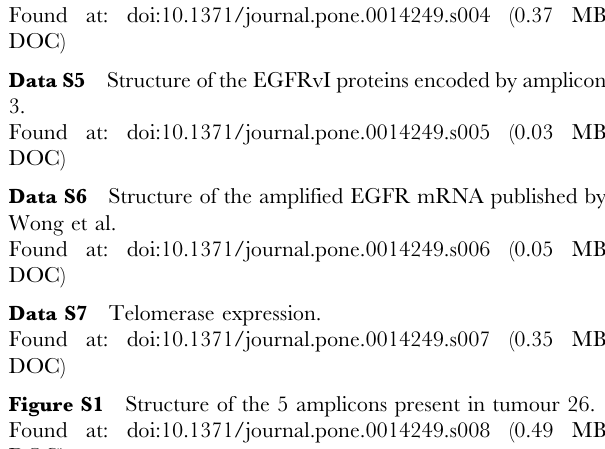
Figure S1 Structure of the 5 amplicons present in tumour 26.